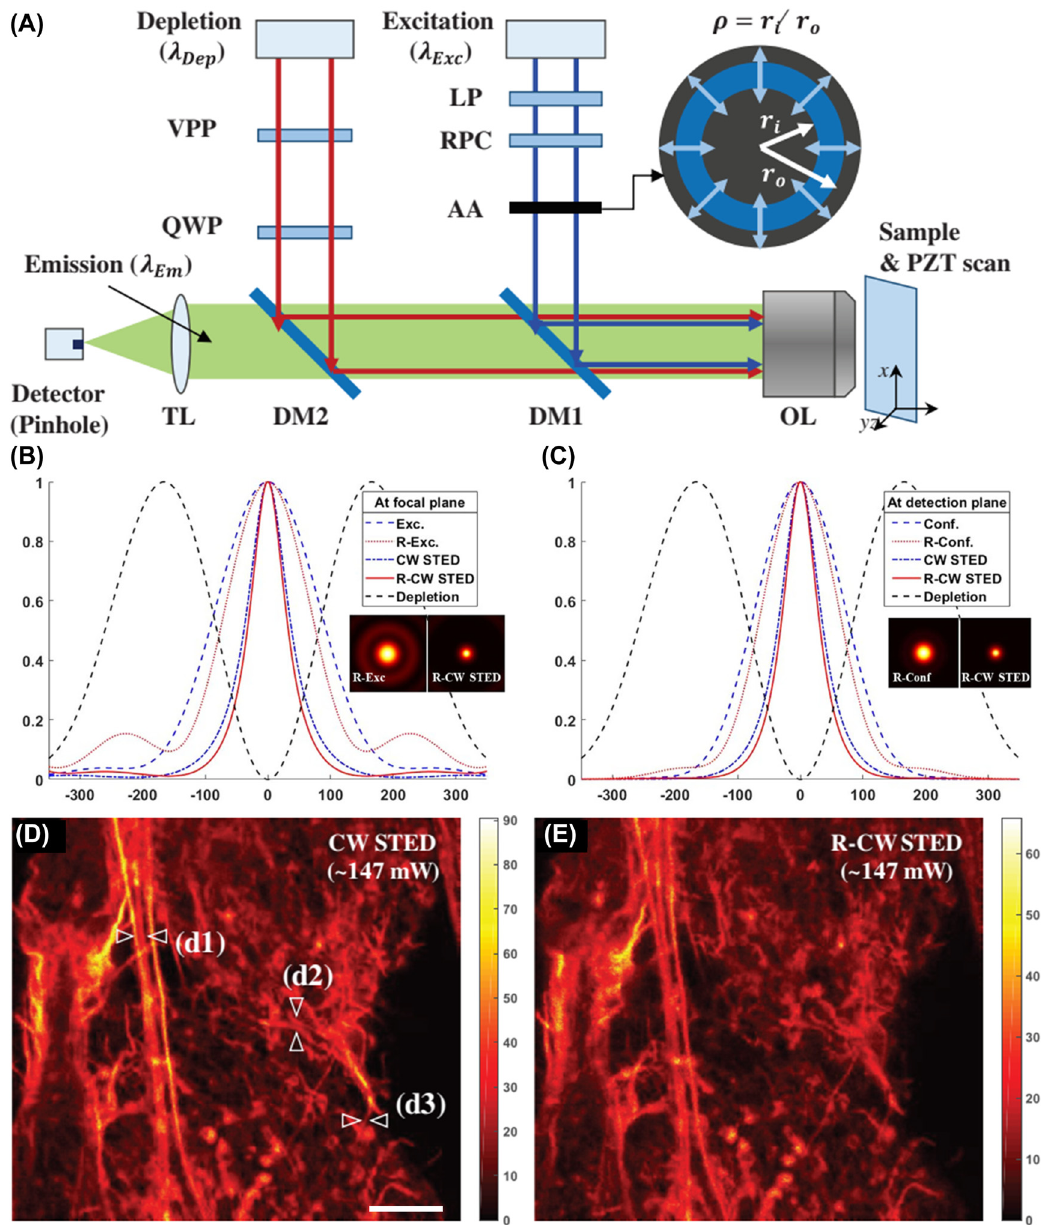
Figure 10: RVB-illuminated CW STED